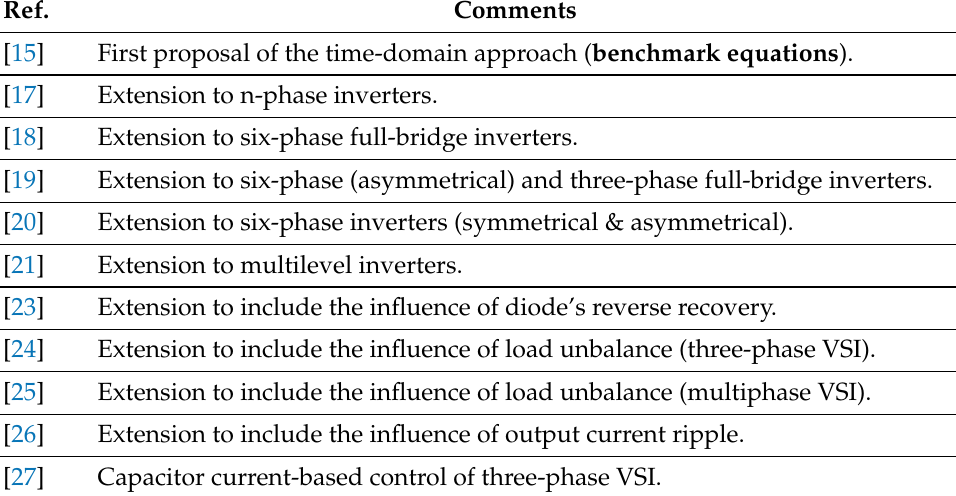
Table 1. State-of-the-art of the time-domain approach.